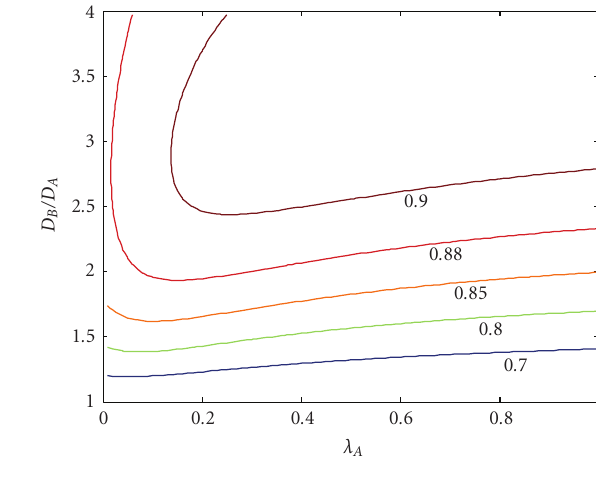
Figure 8: Contour of HP stage e ffi ciency.